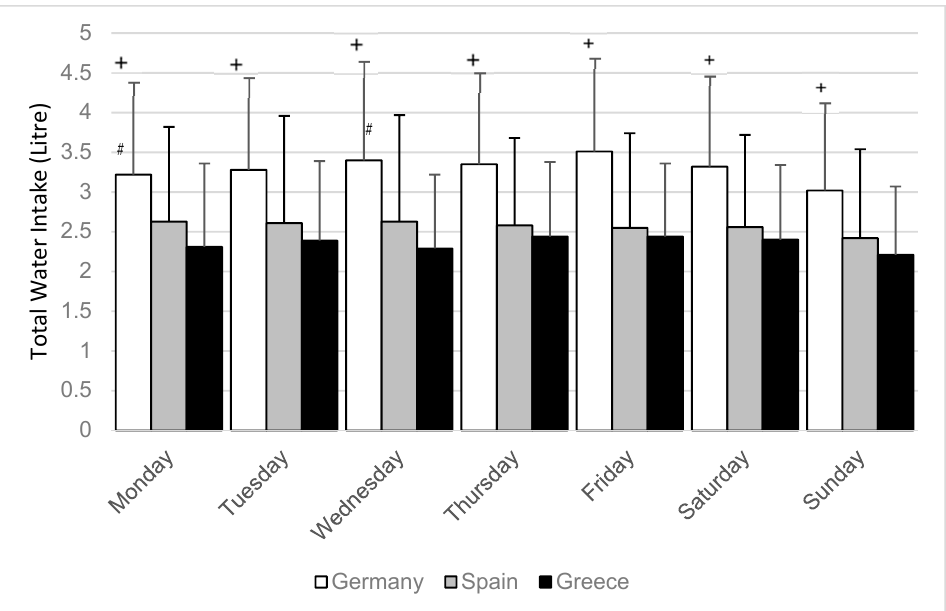
Figure 1. Mean total water intake (L/day) among weekdays with respect to country. p -values derived through Tahame–T2 test for comparison between countries. + significantly different on all weekdays for the German subjects compared to the Greek and Spanish ( p < 0.001). # significant different for the Spanish subjects compared to the Greek on Mondays and Wednesdays ( p < 0.05).